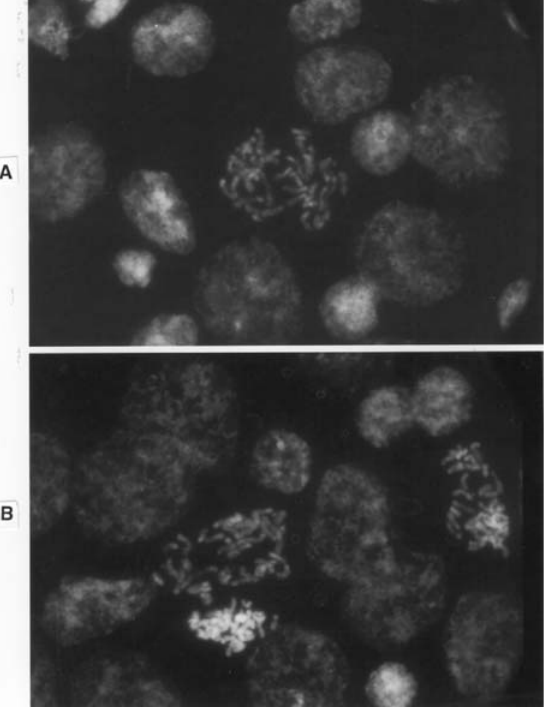
Figure 4 - Metaphases of female Trigona chanchamayoensis (A) and Trigona recursa (B) after staining with DA/CMA 3